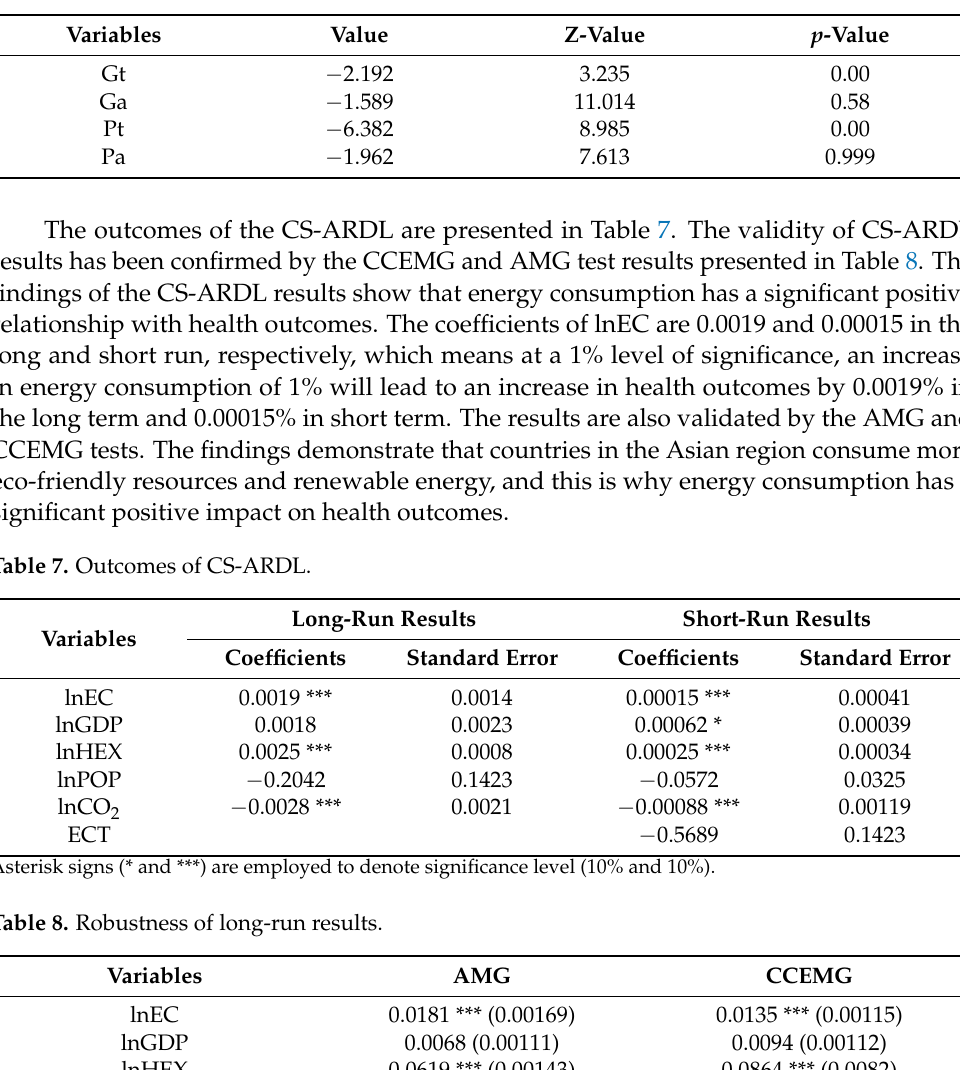
Table 6. Results of Westerlund test for cointegration.